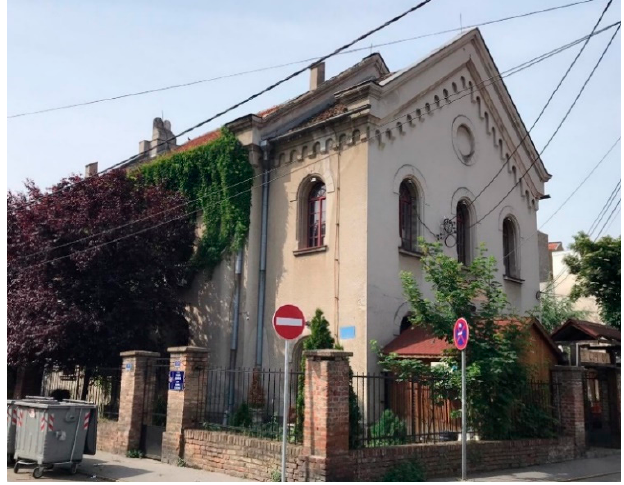
Figure 3. Zemun synagogue today.